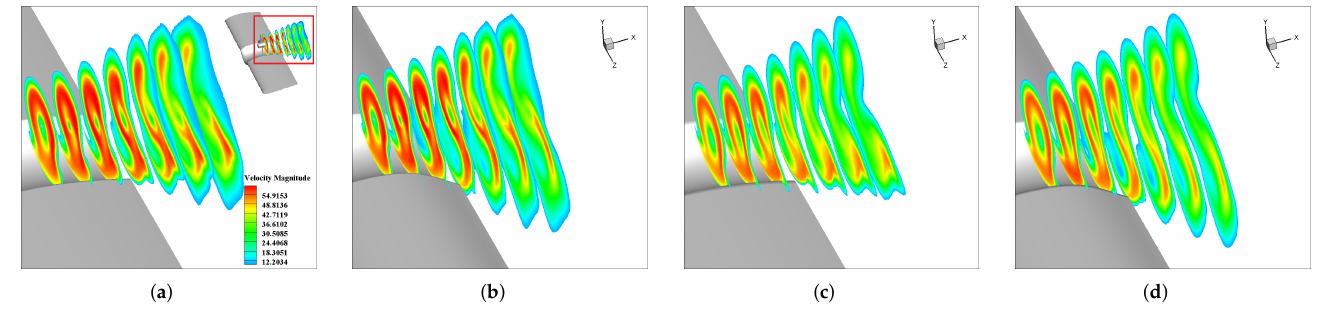
Figure 8. Velocity contours in the propeller wake from Momentum Source Method (MSM) and Sliding Mesh (SLM). ( a ) Config-2(SLM); ( b ) Config-1(SLM); ( c ) Config-2(MSM); ( d )